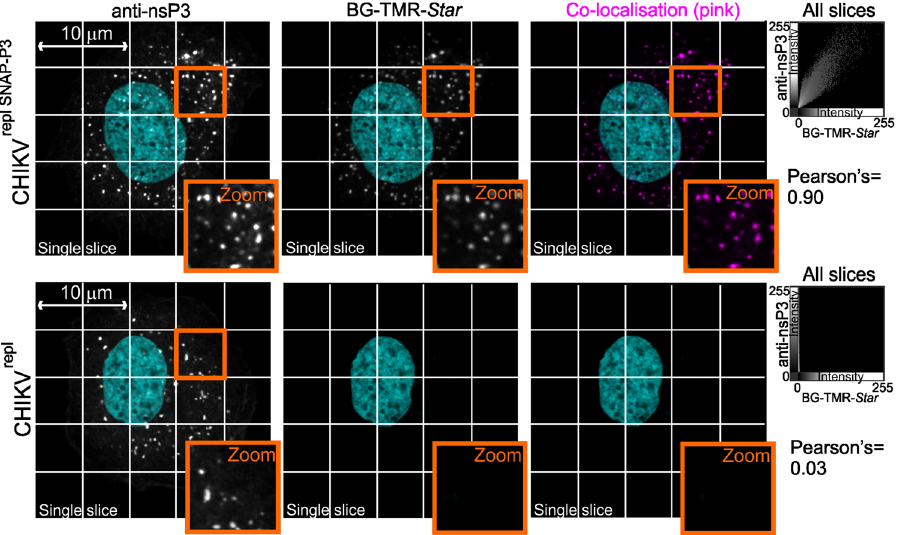
Figure 2. Inserting the SNAP polypeptide into the CHIKV replicon allows for specific labelling of nsP3 with synthetic probes. Confocal microscopy of fixed samples labelled for nsP3 and the SNAP-tag. HuH-7 cells were transfected with SNAP-tagged CHIKV repl SNAP-P3 RNA or untagged CHIKV repl RNA. BG-TMR- Star substrate stained SNAP-nsP3, rabbit antiserum detected nsP3, and Z-stacks were acquired by confocal microscopy. Individual images show single, central slices extracted from the Z-stack. Scatterplots show fluorescence intensity of all voxels from nsP3-specific and BG-TMR- Star -specific imaging channels (for entire Z-stack). Note that for CHIKV repl , the data points line up along the y-axis due to low fluorescence intensity in the BG-TMR- Star channel. Pearson’s = Pearson’s correlation coefficient. Imaris software was used to extract single slices from Z-stacks, create the pseudo-coloured co-localisation channel (pink) and to plot fluorescence intensities on 2-D scatterplots. Data was acquired with a Zeiss LSM 700 confocal system equipped with a Plan-Apochromat 63 × oil objective (1.4 numerical